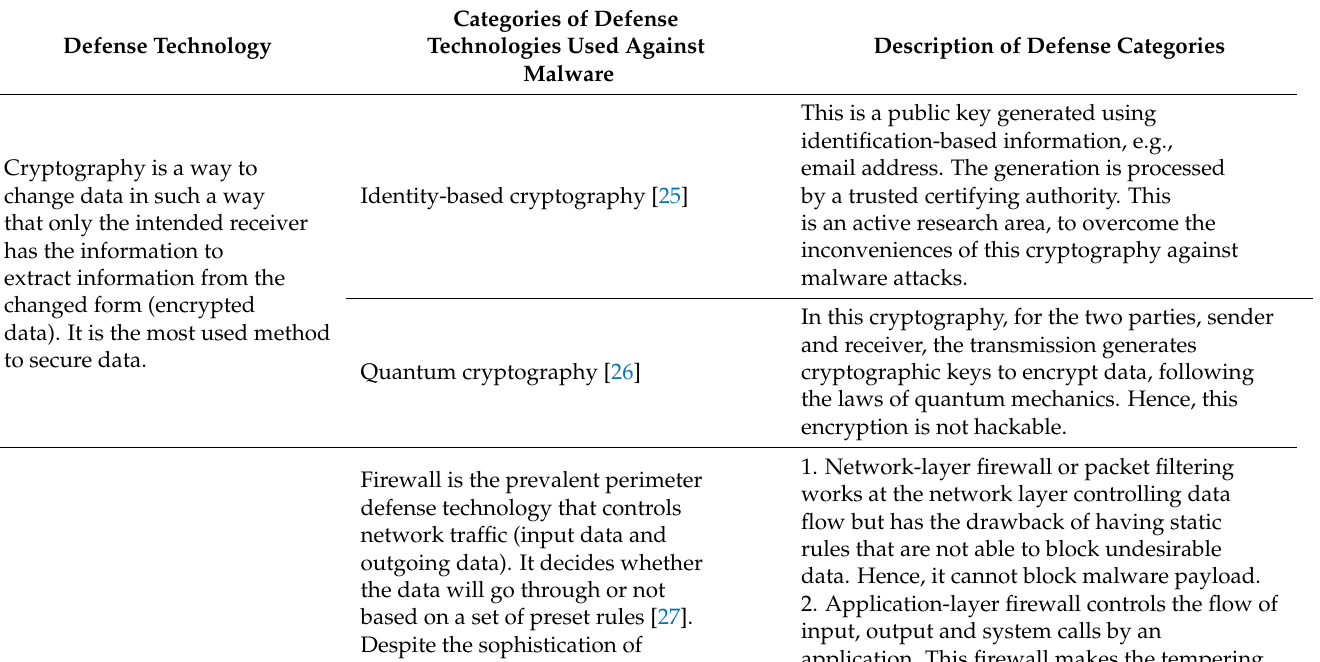
Table 1. Defenses to protect data against